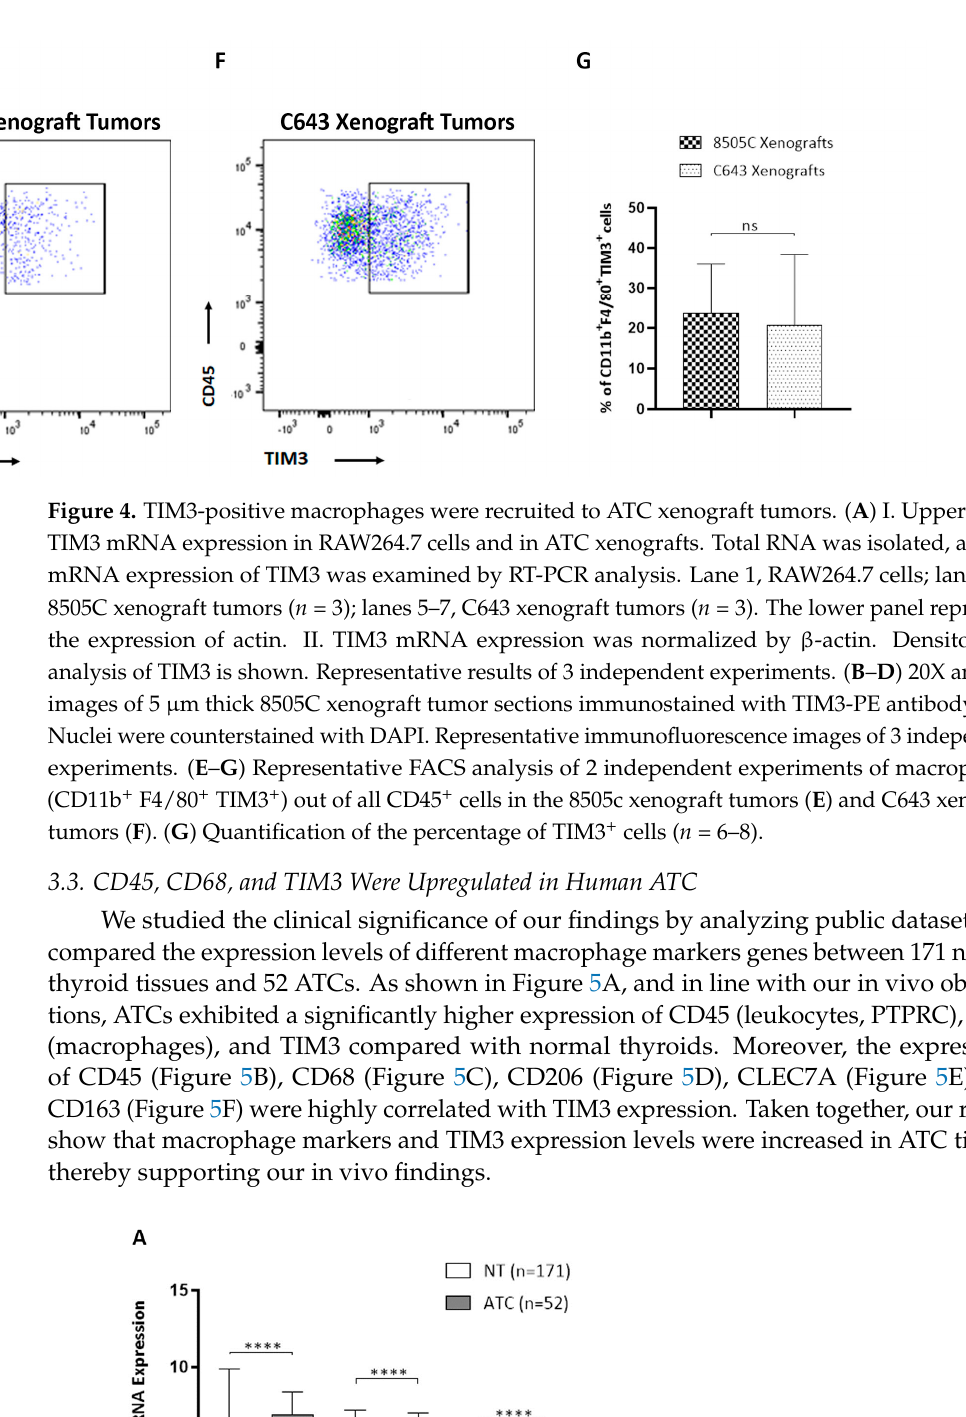
Figure 5. Macrophage markers, CD45 and CD68, and TIM3 expression in ATC. ( A ) Boxplots show- ing CD45, CD68, and TIM3 gene expression in normal thyroids (NT) and ATC samples derived from GEO datasets (GSE3467, GSE3678, GSE6004, GSE29265, GSE33630, GSE53157, GSE35570, GSE60542, GSE29265, GSE33630, GSE76039, and GSE65144). Statistical significance by Mann–Whitney test; ****